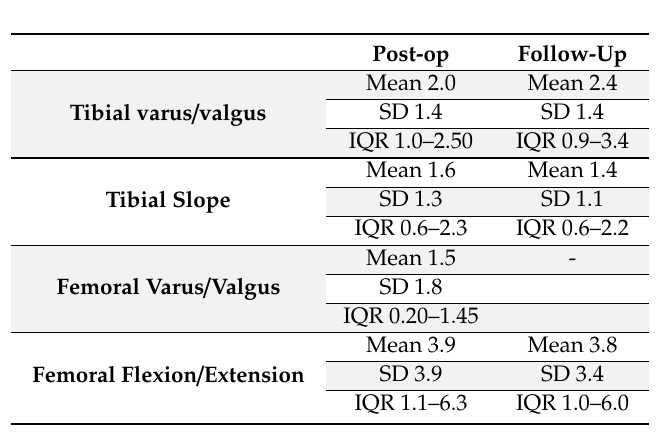
Table 4. Extent of deviations from recommended ranges for all angles, measured postoperatively and at